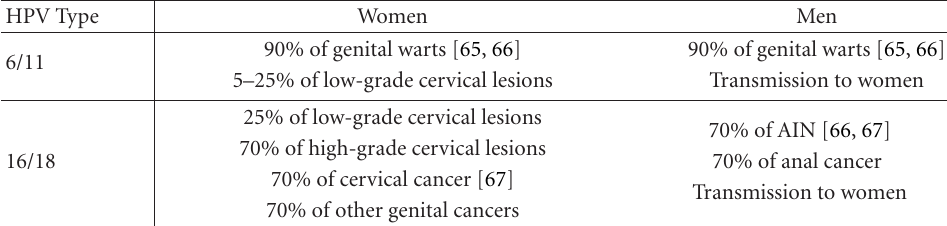
Table 5: Contribution of HPV types 6, 11, 16, and 18 to HPV-related